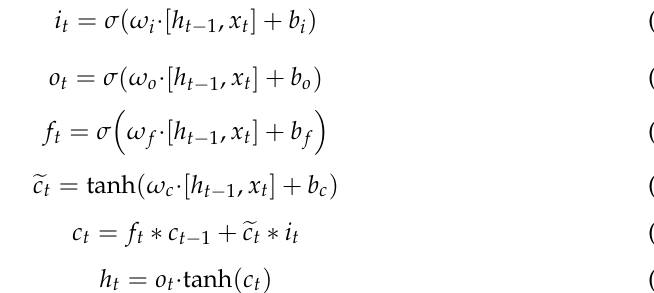
Figure 2. Comparison of ordinary convolution kernel and dilated convolution kernel. ( a ) Conven- tional 1 × 3 convolution kerel; ( b ) dilated convolution 1 × 3, dilation rate is 2.